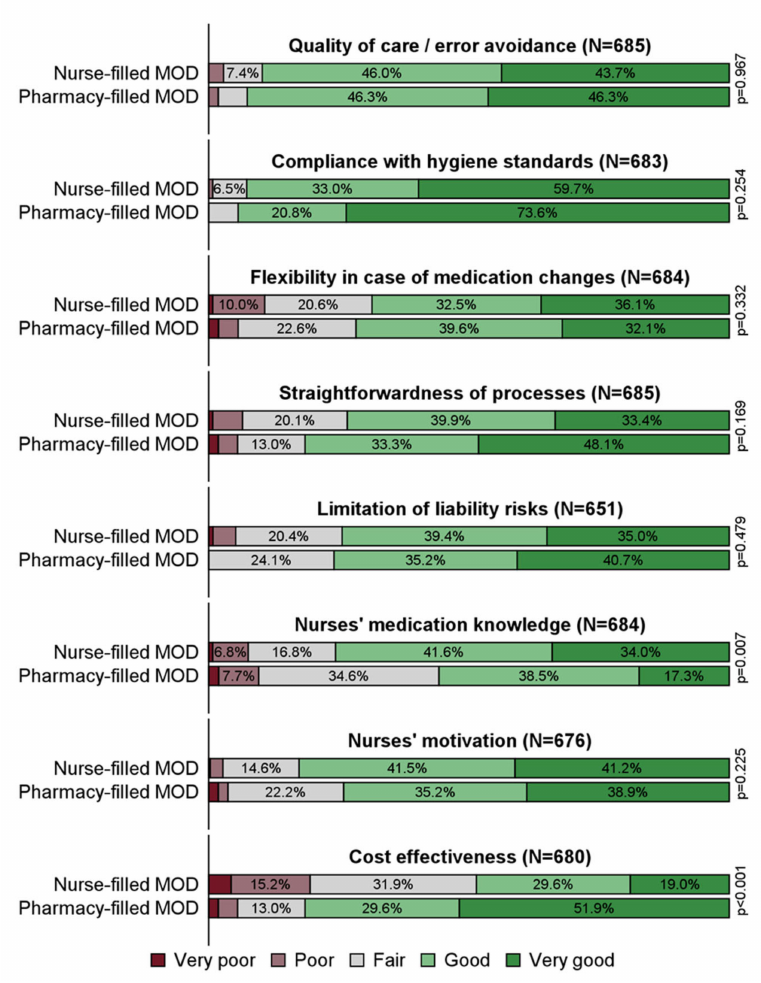
Figure 2. How well do your current practices fulfill the respective criteria for providing long-term medication? Answers by filling responsibility, N = number of valid answers for the respective criterion. MOD: medication organization